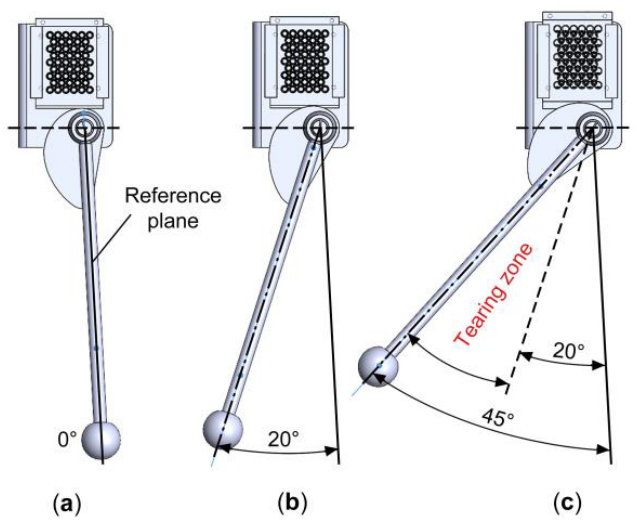
Figure 14. Rotation angles of the grain-cutter crank with implemented a commercial knife: ( a ) rotation angle 0 ◦ ; ( b ) rotation angle 20 ◦ ; ( c ) “grain tearing”.